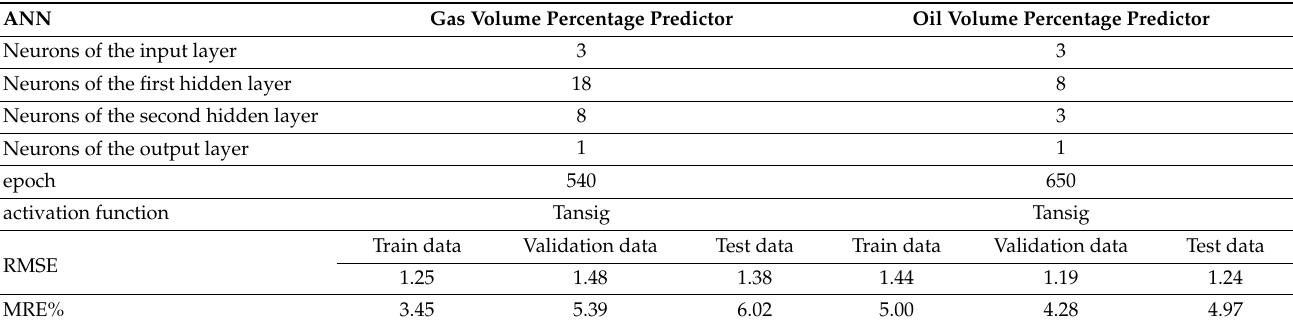
Table 1. The specifications of predictor MLP neural networks.